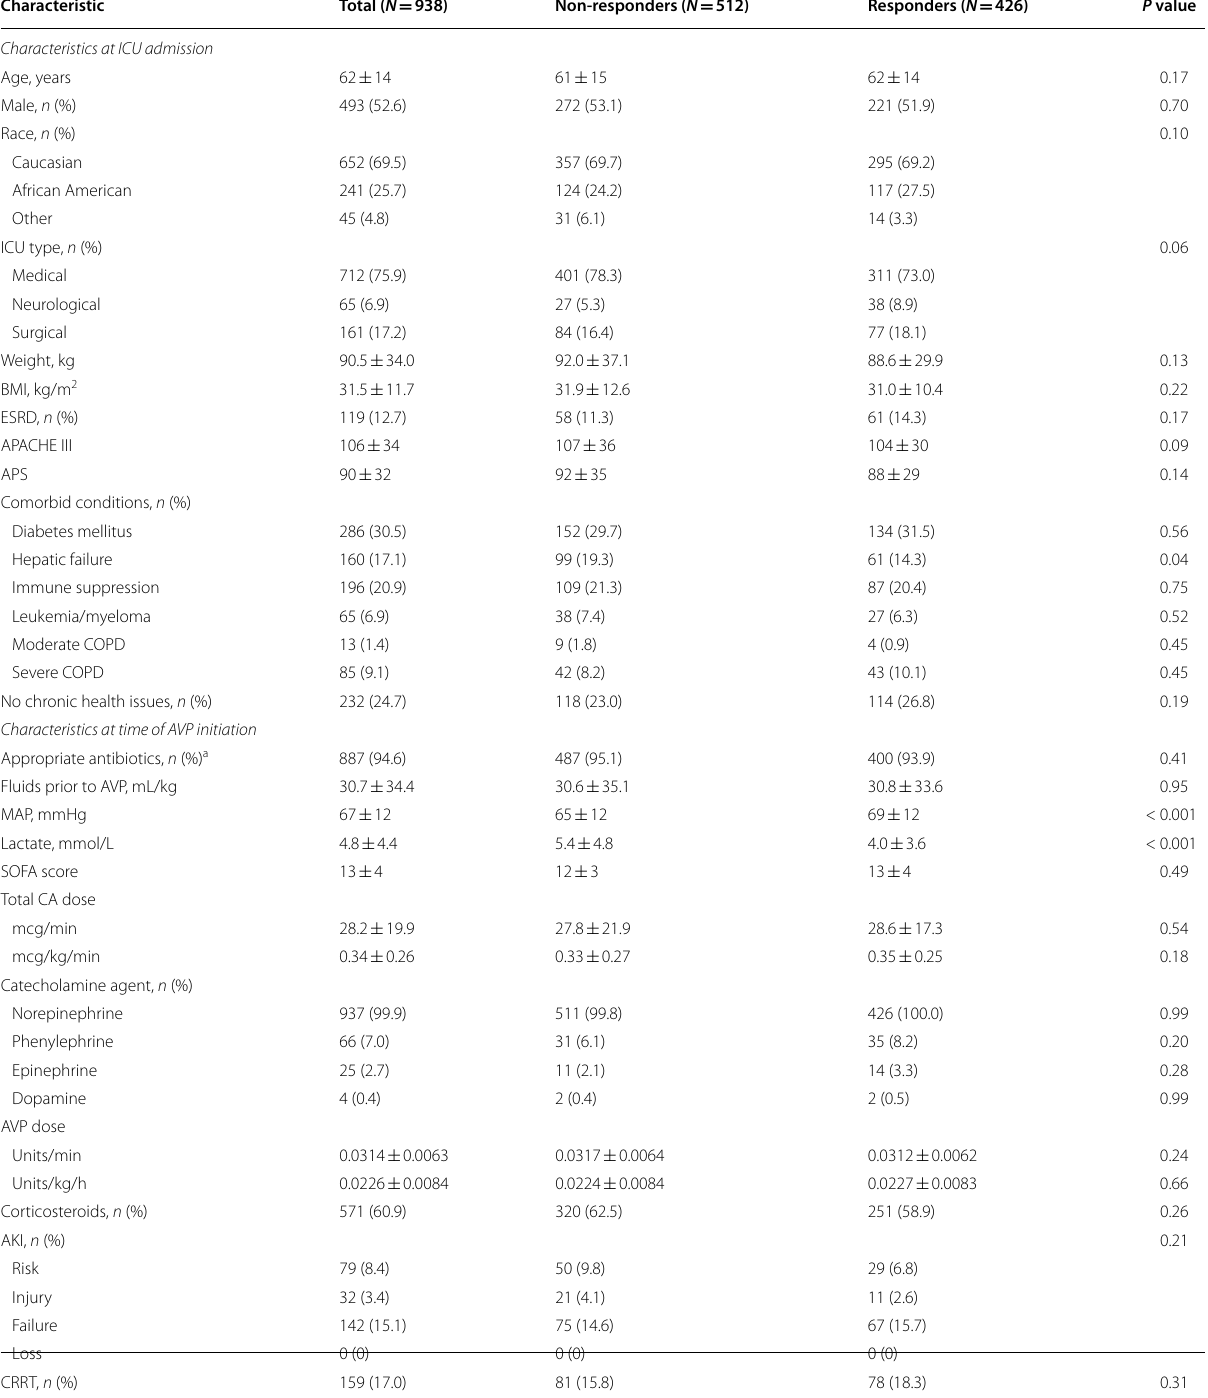
Table 1 Baseline